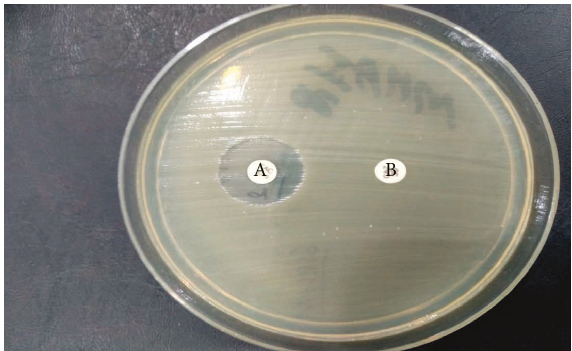
Figure 1: Confirmation of ESBL production by combined disc test in Escherichia coli. A � ceftazidime (30mcg) with clavulanic acid (10mcg) and B � ceftazidime (30mcg), in this study. Table 2: ESBL production among Gram-negative isolates.